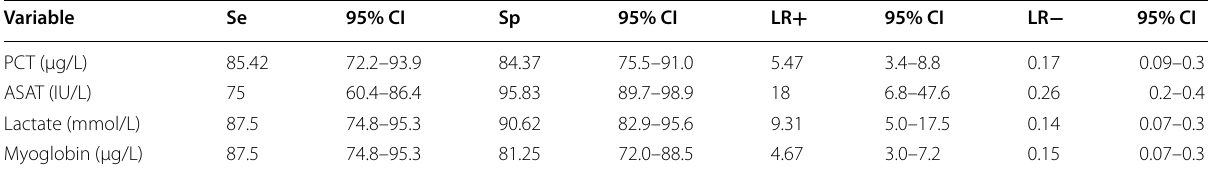
Table 4 Best sensitivity and specificity according to the better likelihood ratio, leading to the points of the score for the diagnosis of acute bowel ischemia Variable